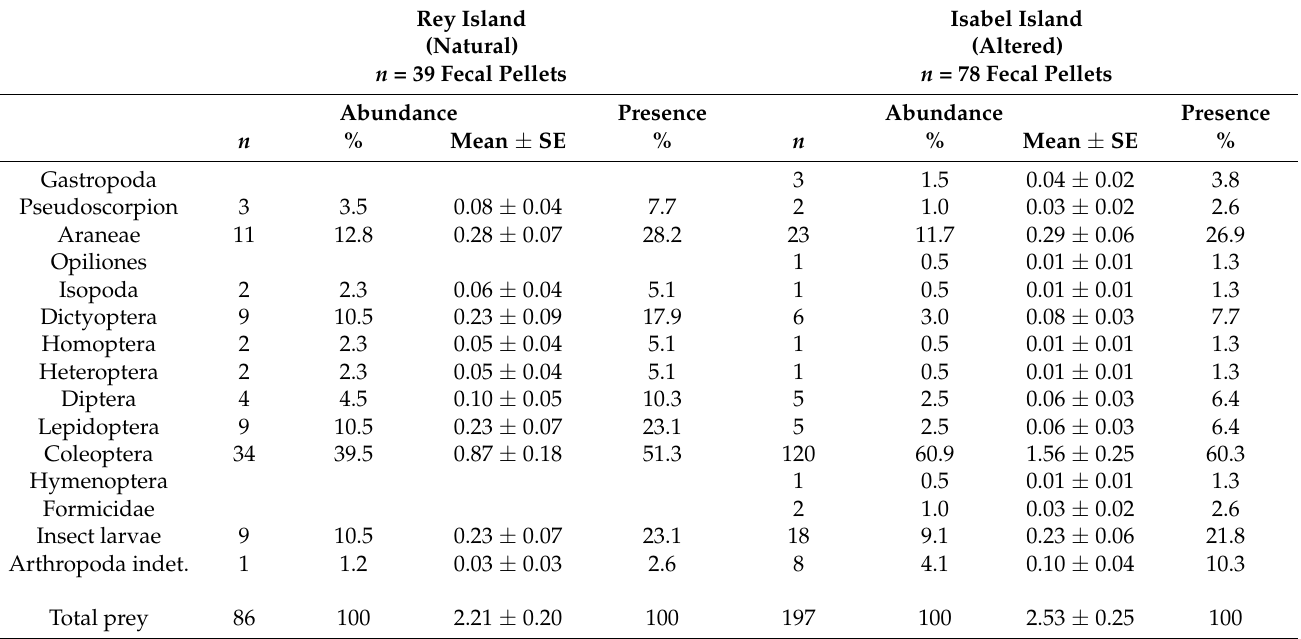
Table 3. Composition of the diet of the Moorish gecko, Tarentola mauritanica , in two of the Chafarinas Islands with different levels of anthropogenic disturbance (natural: Rey; altered: Isabel), based on 117 fecal samples collected from live geckos. ‘Abundance’ (total number, % and mean number ± SE of prey in each fecal sample) and ‘Presence’ (percentage of fecal samples containing a particular prey item) are shown.